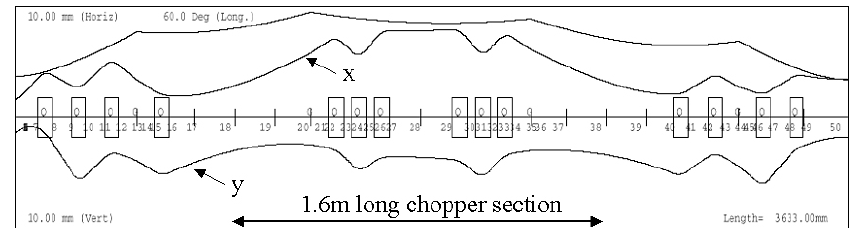
FIG. 4. Trace 3D beam envelope profiles in the MEBT before